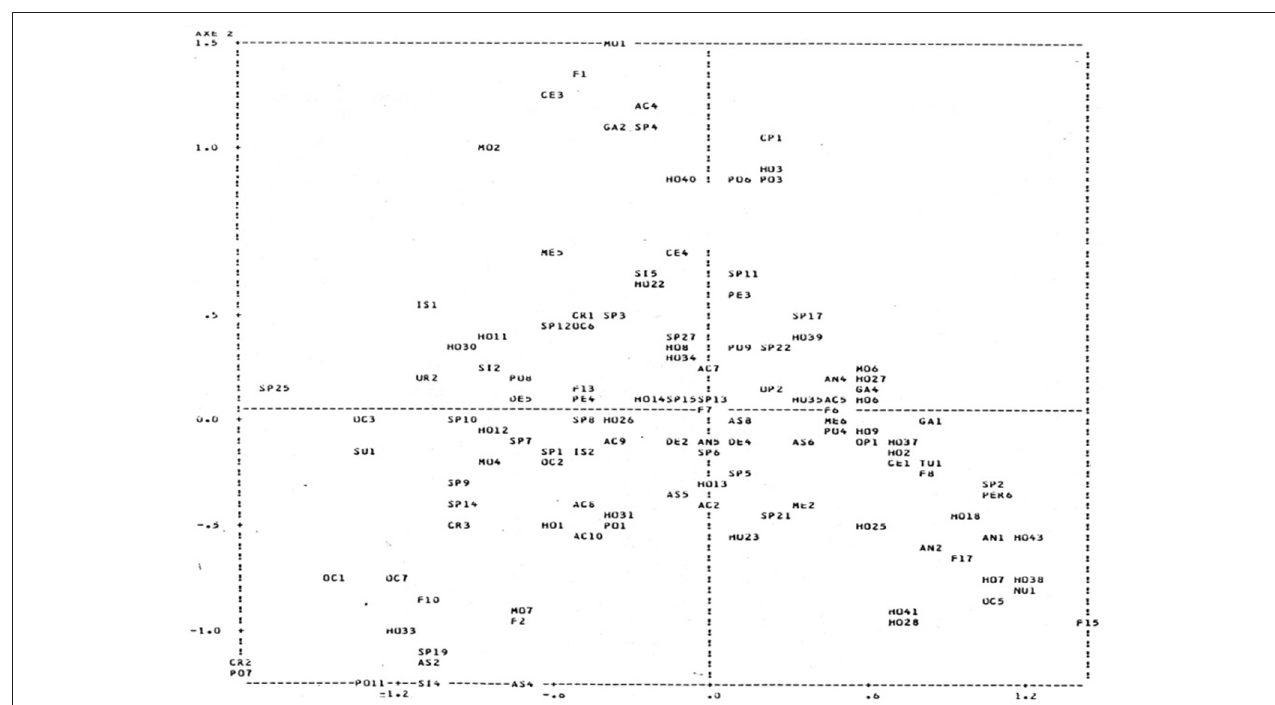
FIGURE 6 | Multi-Dimensional Scaling (MDS) Plot to show the degrees of similarity and difference in distribution patterns of the principal taxa recorded in NIXO 45. (http://unesdoc.unesco.org/images/0014/001495/149556f.pdf, volume 1 Figure